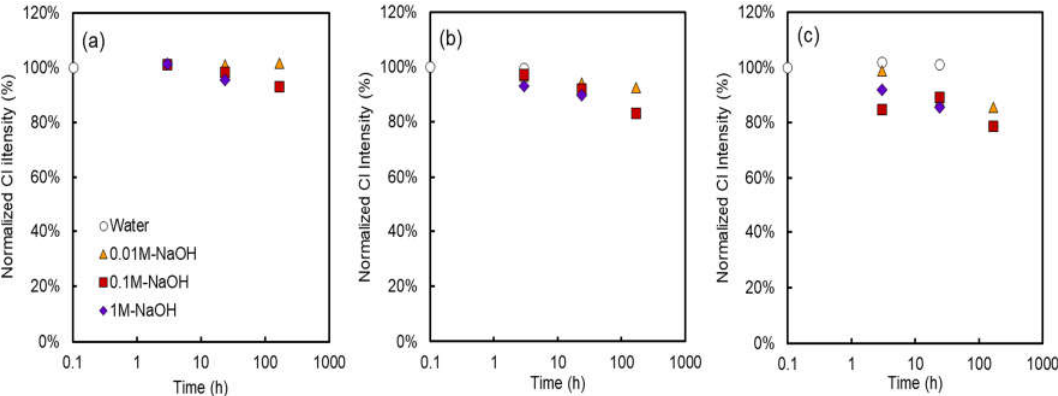
Figure 5. Normalized chloride intensity as a function of the time, concentration, and temperature of the alkali immersion test: ( a ) 40 °C, ( b ) 60 °C, ( c ) 80 °C.